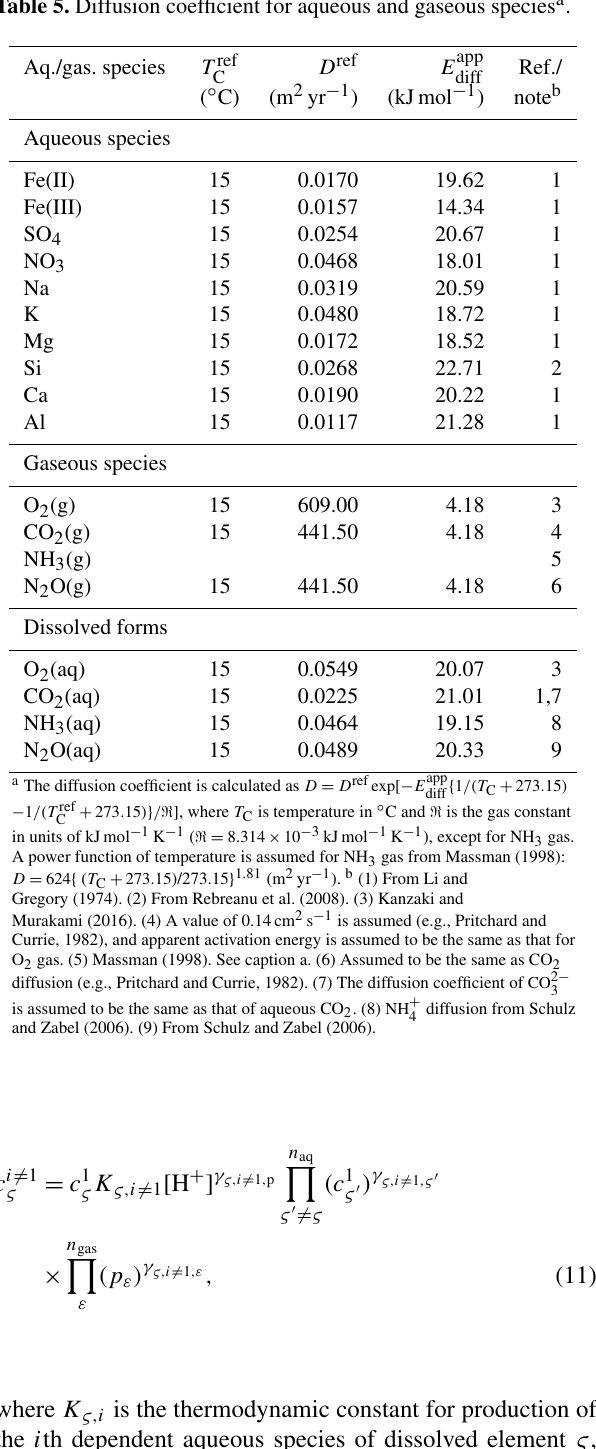
Table 5. Diffusion coefficient for aqueous and gaseous species a